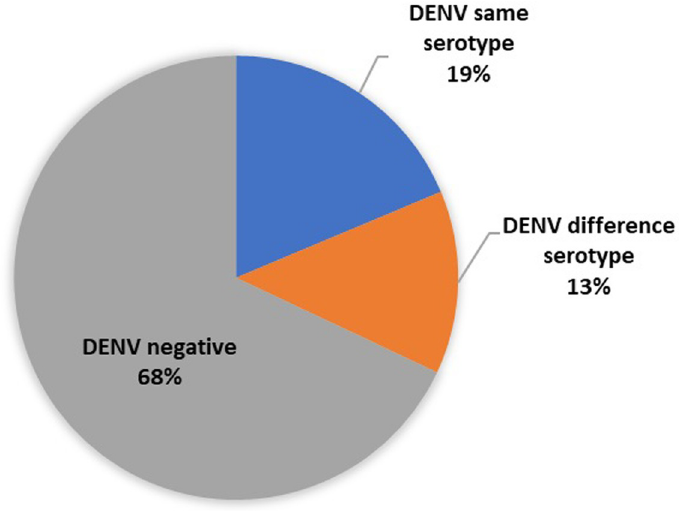
Fig 2. Serotypes in 75 DENV-positive patients from households where corresponding DENV-positive mosquitoes were collected. In 14 households (19%), the serotype in patients and mosquitoes matched each other, i.e. were the same (blue); in 10 households (13%), the serotypes in patients and mosquitoes were the different (orange); and in 51 households (68%) patients were DENV-positive whereas mosquitoes were DENV-negative (grey). More details of the molecular characteristics of DENV-positive patients and mosquitoes are provided in S3